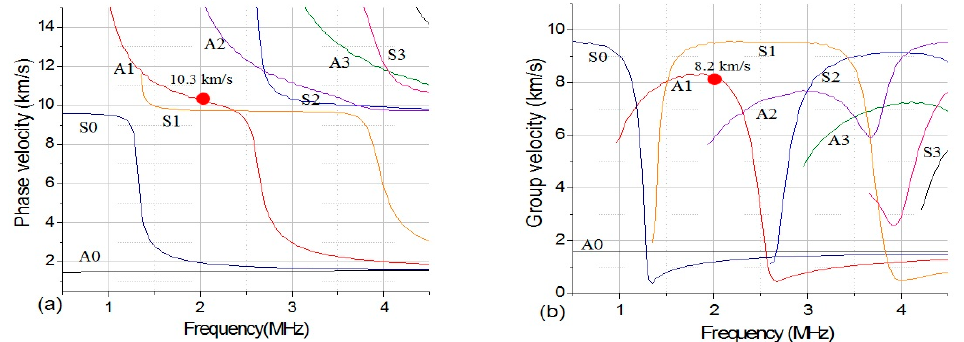
Figure 1. Numerically calculated phase velocity ( a ) and group velocity ( b ) dispersion curves for Lamb wave in the [0] 6 carbon/epoxy laminates, the propagation direction of the waves is along the fiber direction .